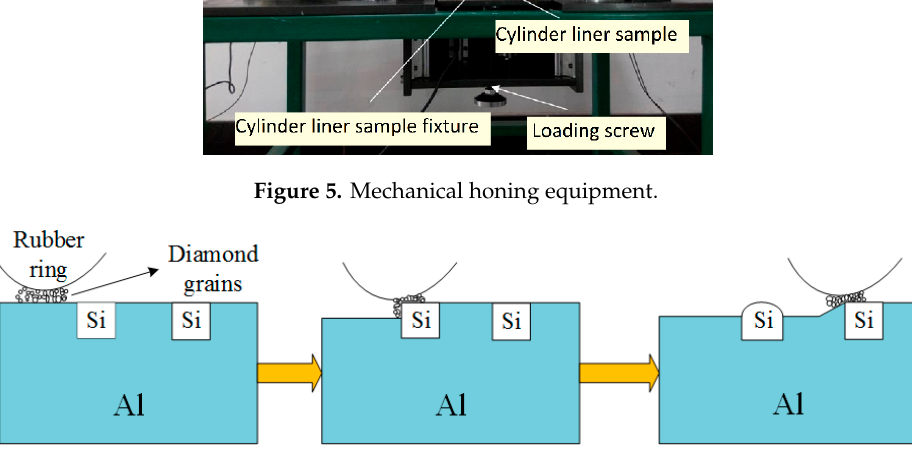
Figure 6. Mechanical honing process of the Al–Si alloy cylinder liner.